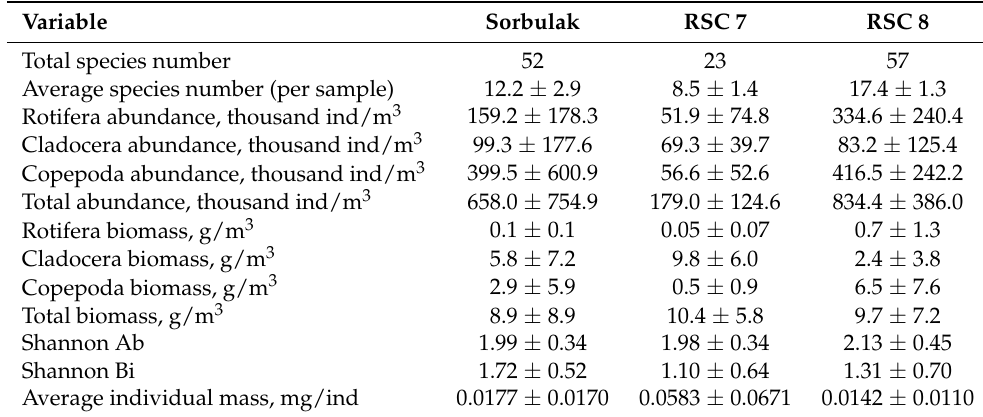
Table 4. Quantitative and structural variables of zooplankton communities in wastewater reservoirs of the Right-Bank Sorbulak Canal system, 2021 (average values with standard deviation).